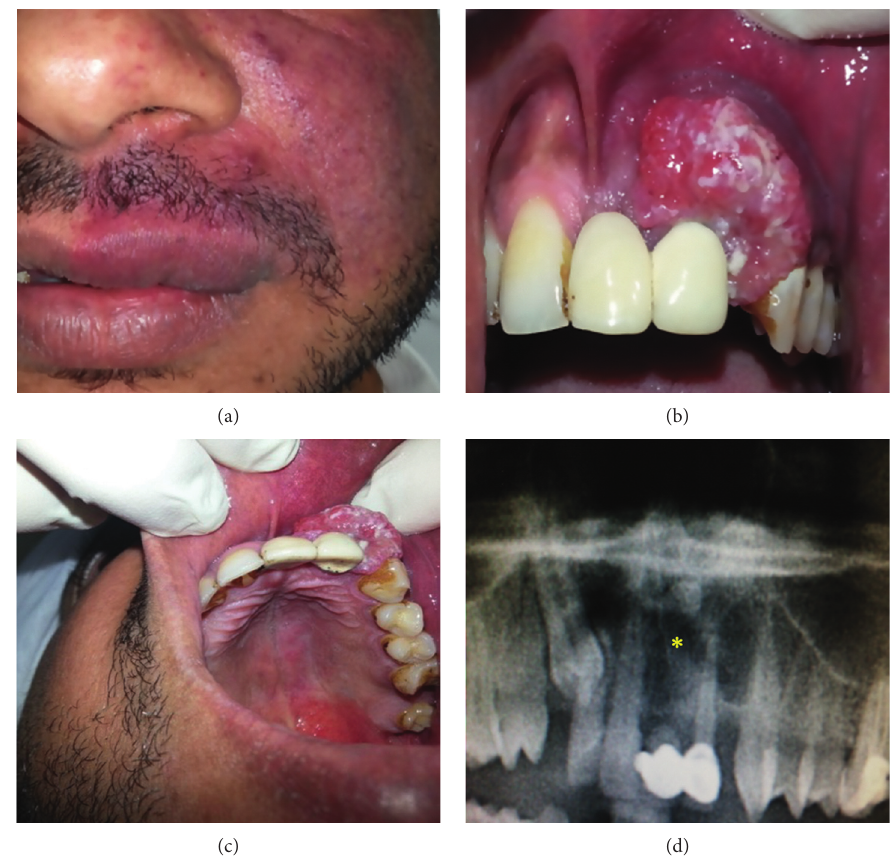
Figure 1: (a) Port-wine stain along the distribution of the maxillary nerve. (b) Clinical view: firm, pedunculated, nontender, and nonpulsatile growth. (c) Palatal view of the lesion. (d) Panoramic view: well-demarcated periapical radiolucency in the alveolar